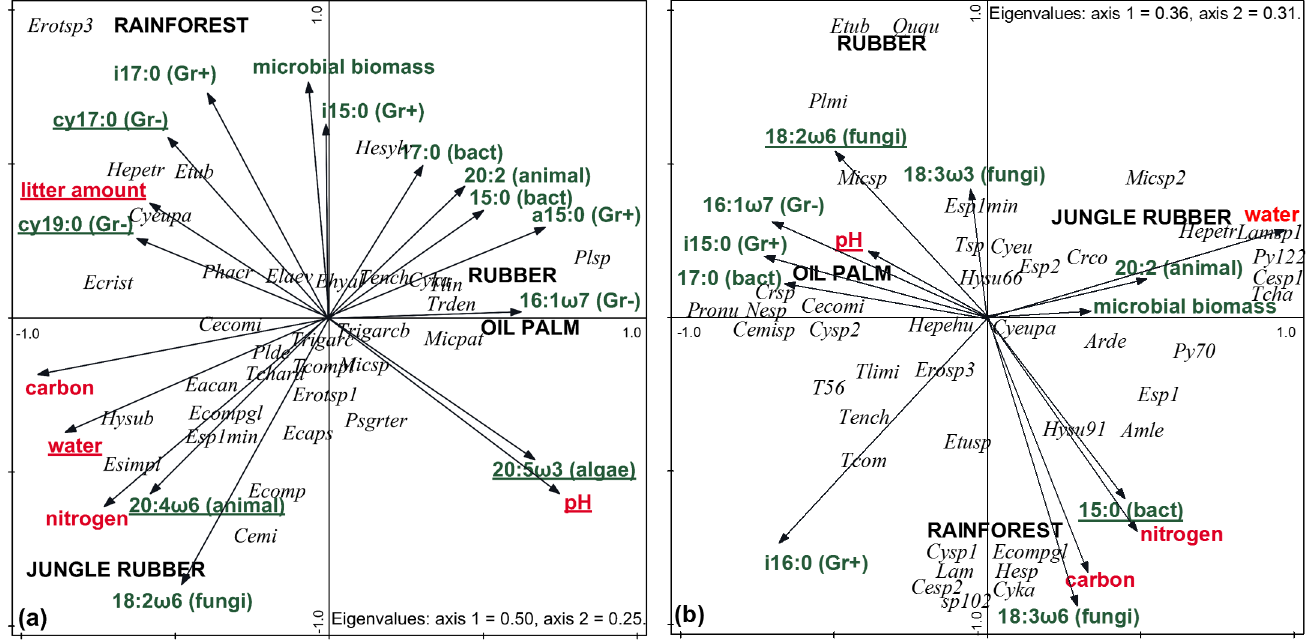
Fig 3. CCA of living testate amoebae of litter (a) and soil (b). Underlined factors are significant; abiotic factors marked in red, biotic factors marked in green; for full species names of testate amoebae see S2 Table; Bact, bacteria, Gr-, Gram-negative bacteria, Gr+, Gram-positive bacteria.